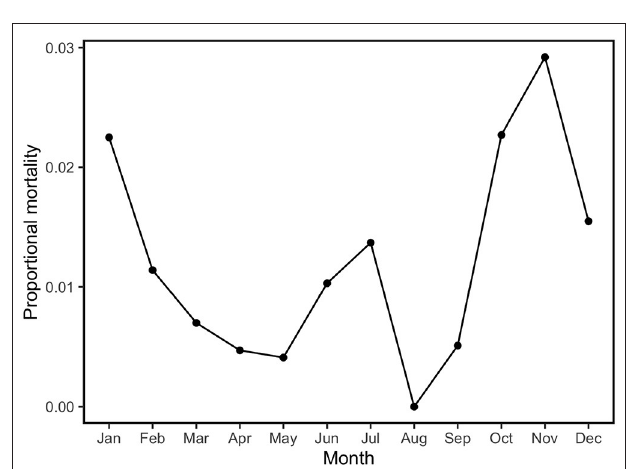
FIGURE 3 | Proportional P. tenuis -induced mortality by month based on necropsies that came into the University of Minnesota Veterinary Diagnostic Laboratory between January 2001 and December 2019 of sheep, llamas, goats, and alpacas. Data represent the number of positive P. tenuis necropsy cases out of the total number of necropsy cases for these species examined in the time